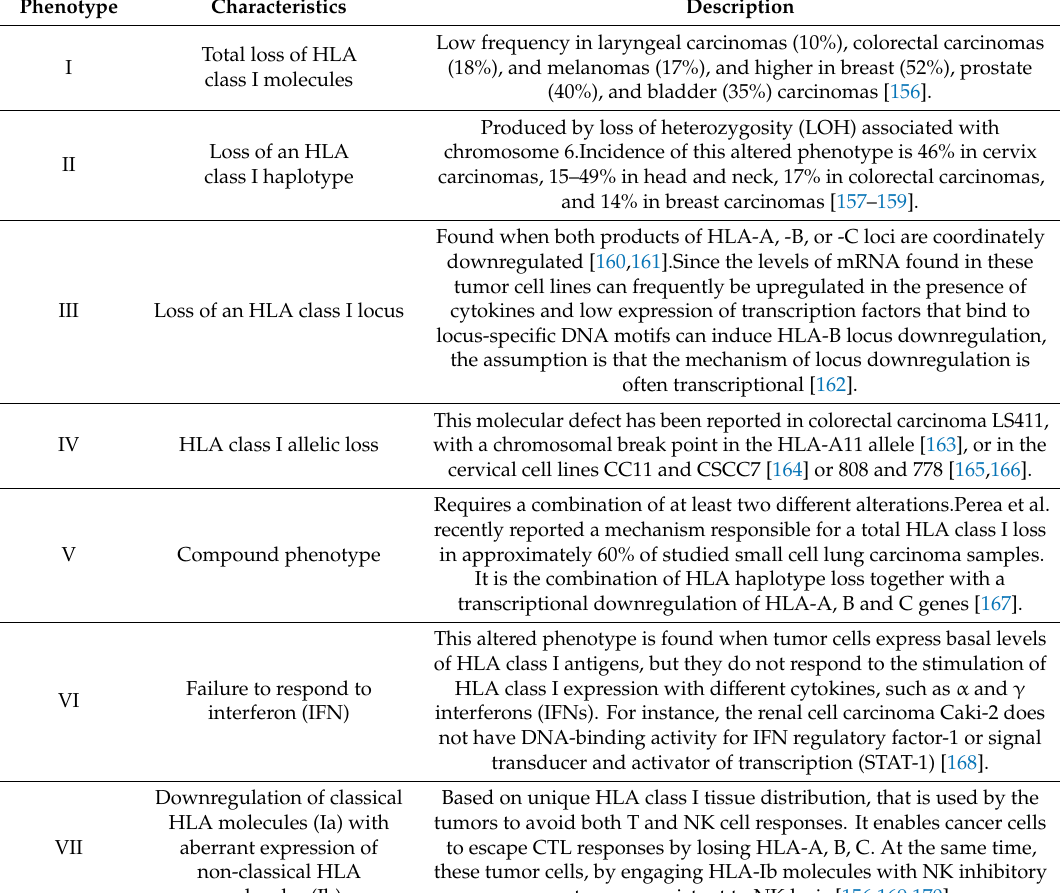
Table 1. HLA class I altered